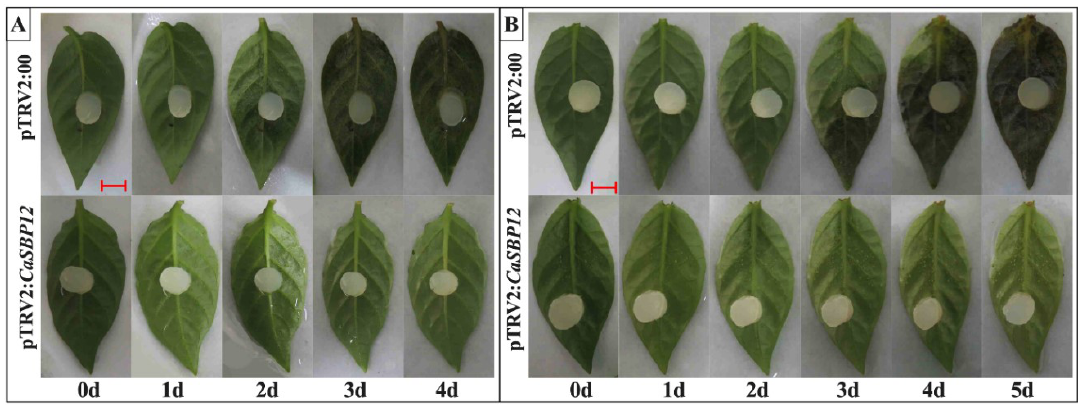
Figure 3. Phenotypes of detached leaves of the CaSBP12 -silenced and control plants after inoculation with P. capsici HX-9 ( A ) or PC ( B ) strains. (d: represents day). The red line used as a scale bar (length 0.8 cm).